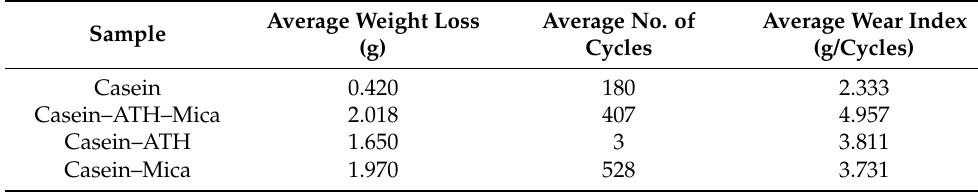
Table 4. A summary of the abrasion resistance results of the coated plywood.